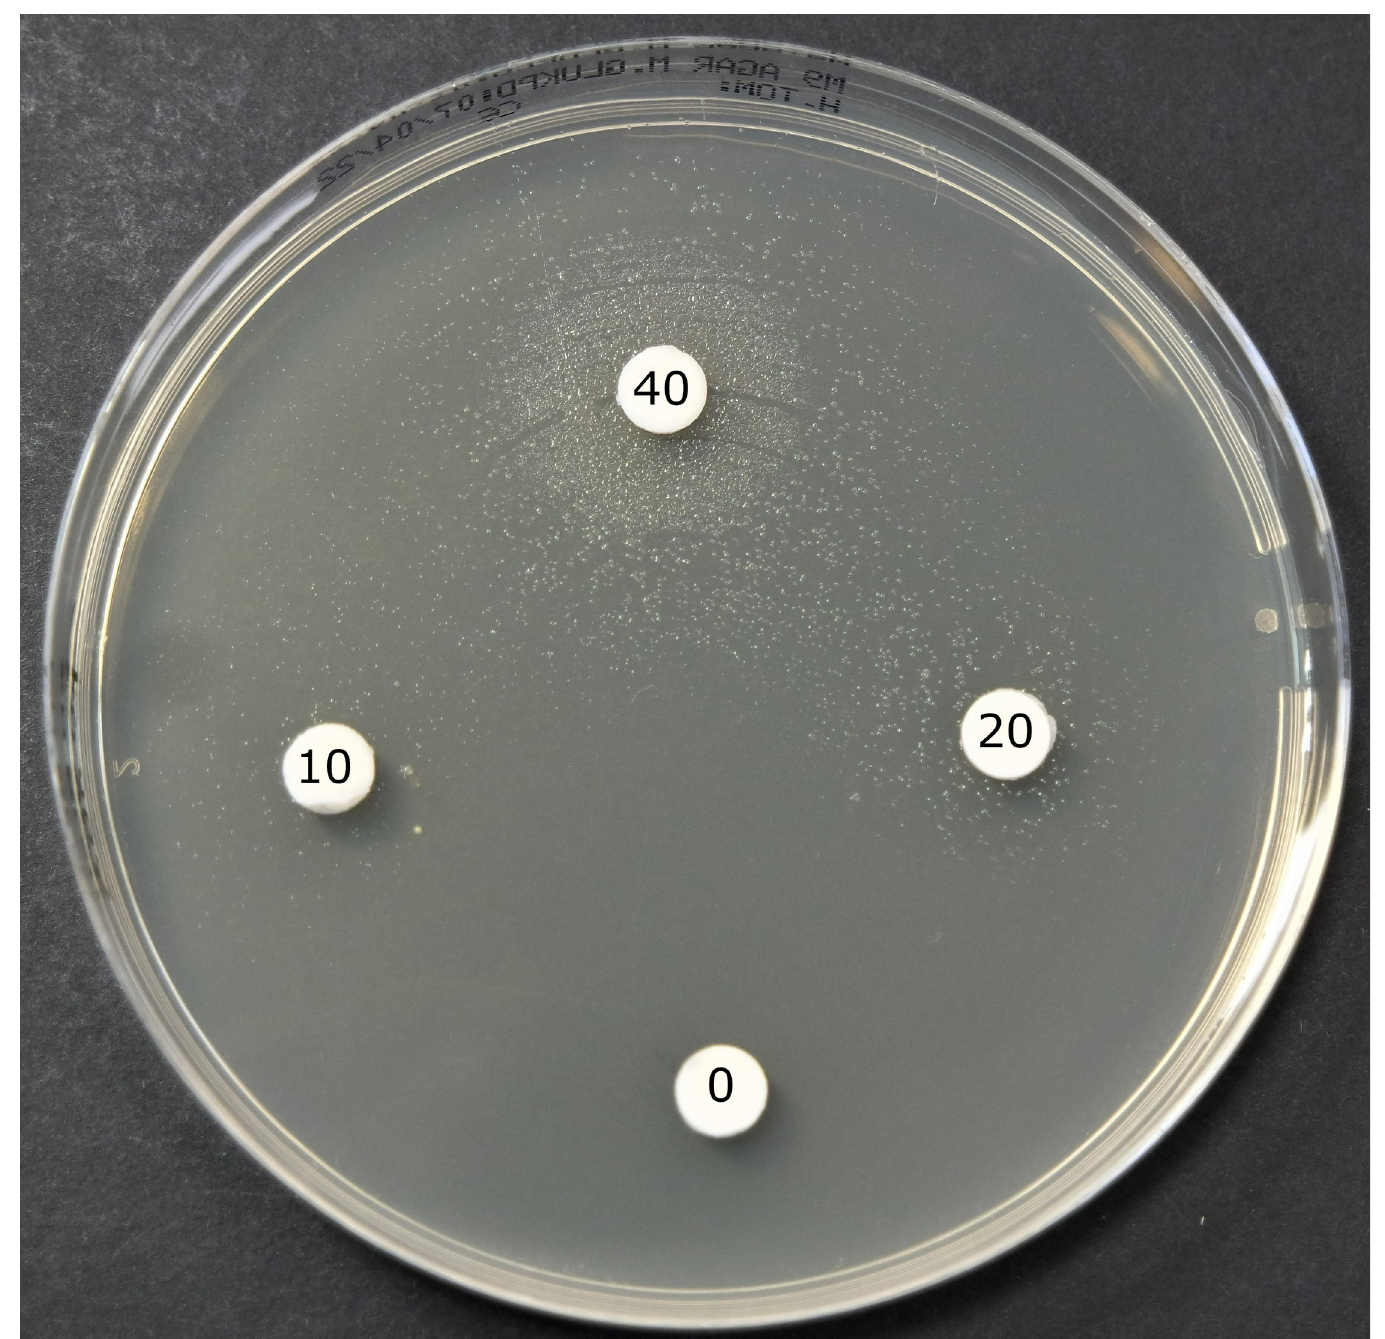
Fig 3. Classical auxotroph test of E . coli SO-ECO15-3 on M9 medium after 24 hours of incubation showing gradual increase in growth surrounding discs with increasing concentrations (10, 20 and 40 μ g/mL as indicated) of thymine and no growth around the negative control (0 μ g/mL).